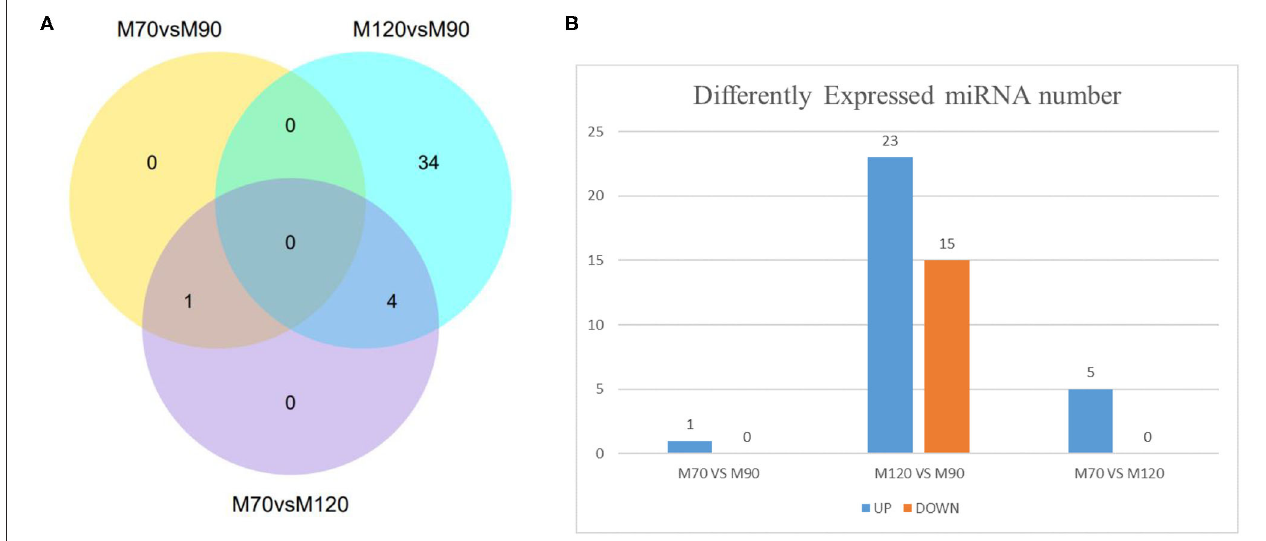
FIGURE 3 | Number of DE-miRNAs at different time stage comparisons. (A) The venn diagram shows the number of DE-miRNAs across three comparisons: M70 vs. M90, M120 vs. M90, M70 vs. M120. (B) The number of up- and downregulated DE-miRNAs across three comparisons: M70 vs. M90, M120 vs. M90, M70 vs. M120, with the threshold set to q <